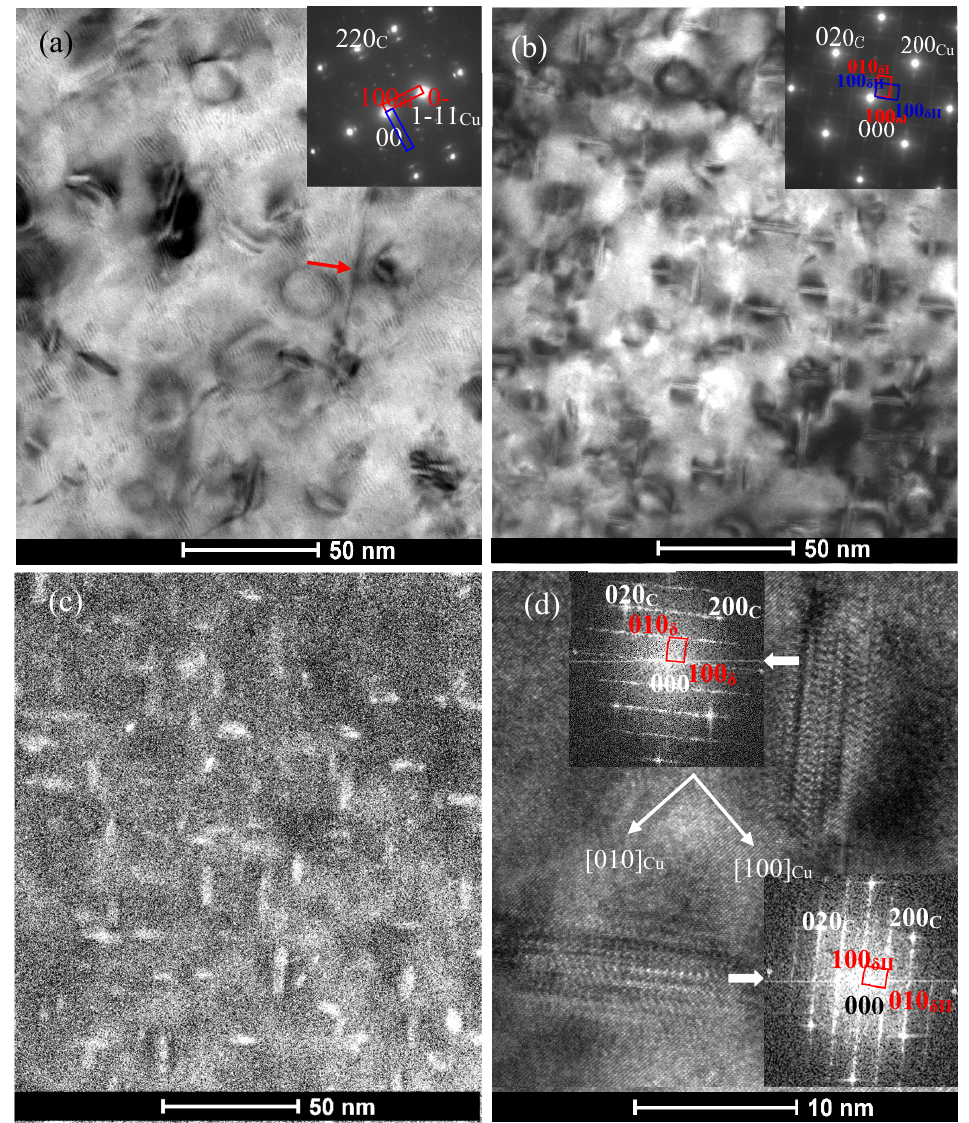
Figure 4. TEM images obtained from the C0 and C1 alloys aged at 500 °C for 4 h ( a ) BF image of C0 alloy and corresponding [ − 112] Cu SAED pattern in the inset, ( b ) BF image of C1 alloy and corresponding [001] Cu SAED pattern in inset. ( c ) DF image of C1 alloy along [001] Cu zone axis, ( d ) HREM image of C1 alloy along [001] Cu zone axis and FFT patterns of two precipitate variants in the inset. Red arrow refers to the P-rich phase.